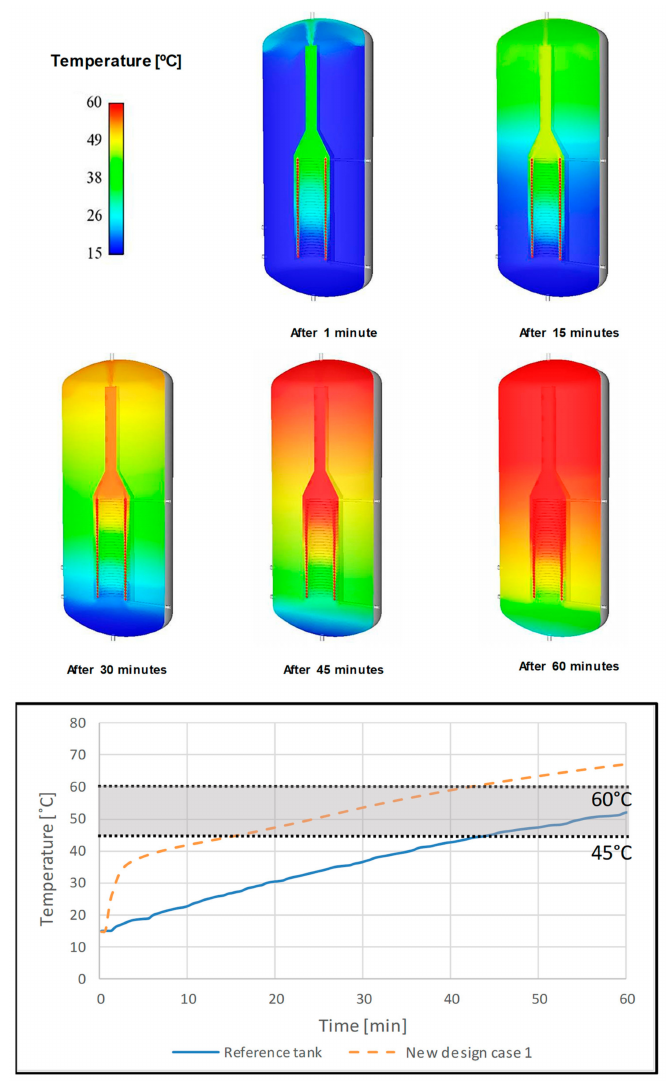
Figure 7. Evolution of the temperature field in simulation 1 and comparison of the DHW temperatures with the reference case (average temperature at the DHW